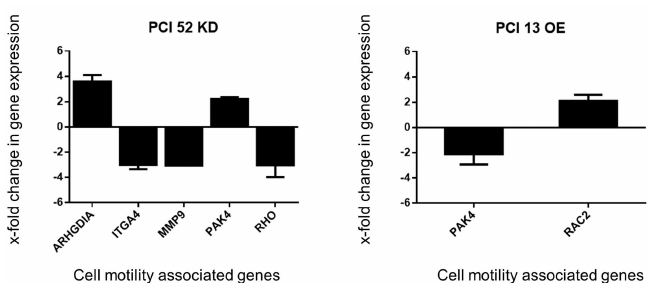
Figure 4. PD-L1-dependent gene expression change. Analysis of PD-L1-dependent expression of cell motility associated genes. Extract from the RT 2 Profiler ™ PCR Array Human Cell Motility for genes relevant to cytoskeletal organization. PD-L1 modulation a ff ects various genes associated with Rho-GTPaseregulation. Onlygeneswithmorethana2.0-foldchangeingeneexpressionwereconsidered to be relevant for evaluation. KD = siRNA knockdown of PD-L1. OE = plasmid overexpression of PD-L1. For qPCR, 25 ng of cDNA was used. The results were expressed as means ± SD; n = 4.